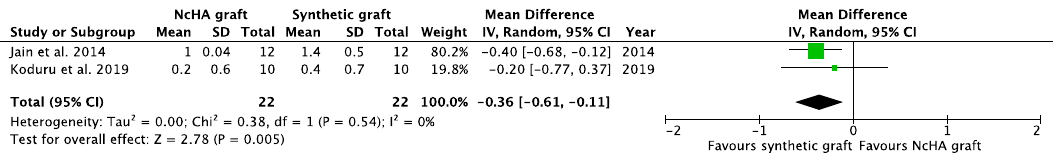
Figure 8. Forest plots demonstrating the comparison of NcHA graft versus synthetic graft (REC change). NcHA: nanohy- droxyapatite; IV: inverse variance; SD: standard deviation; Total: number of patients; 95% CI: confidence interval.